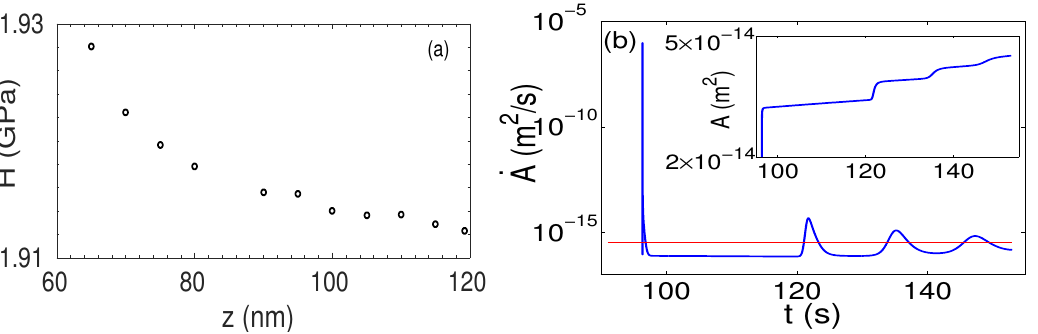
Figure 9. ( a ) Hardness calculated by unloading the indenter from points that have nearly the same load values but two distinct values of z pr and points that have two distinct values of the load for nearly ( z ) the same value of z pr ; ( b ) plot of dA as a function of time. The red line corresponds to the rate of area dt ˙ F = 3.3 × 10 − 16 /m 2 . The inset shows that the A increases in steps, increase due to applied force rate 0 σ m after